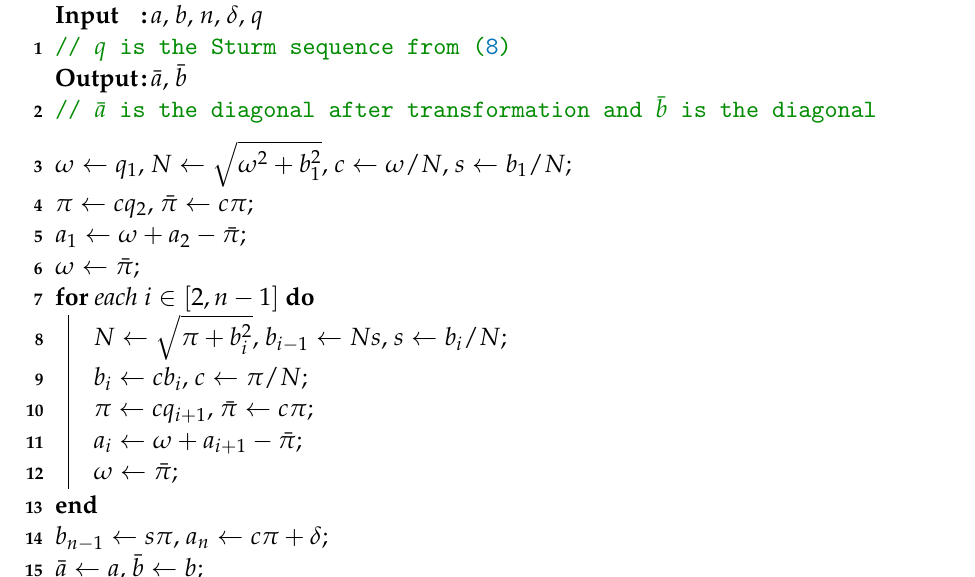
Algorithm 5: Modified QR iteration with the implicit